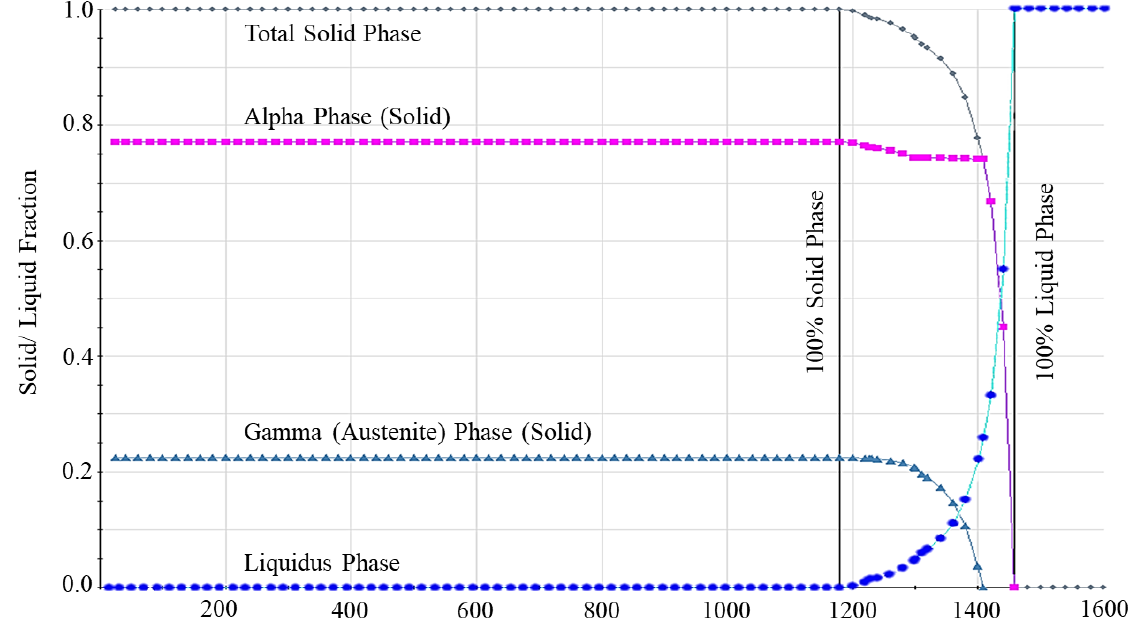
Figure 5. The fraction of liquid and solid phase vs. temperature for 17-4 PH.